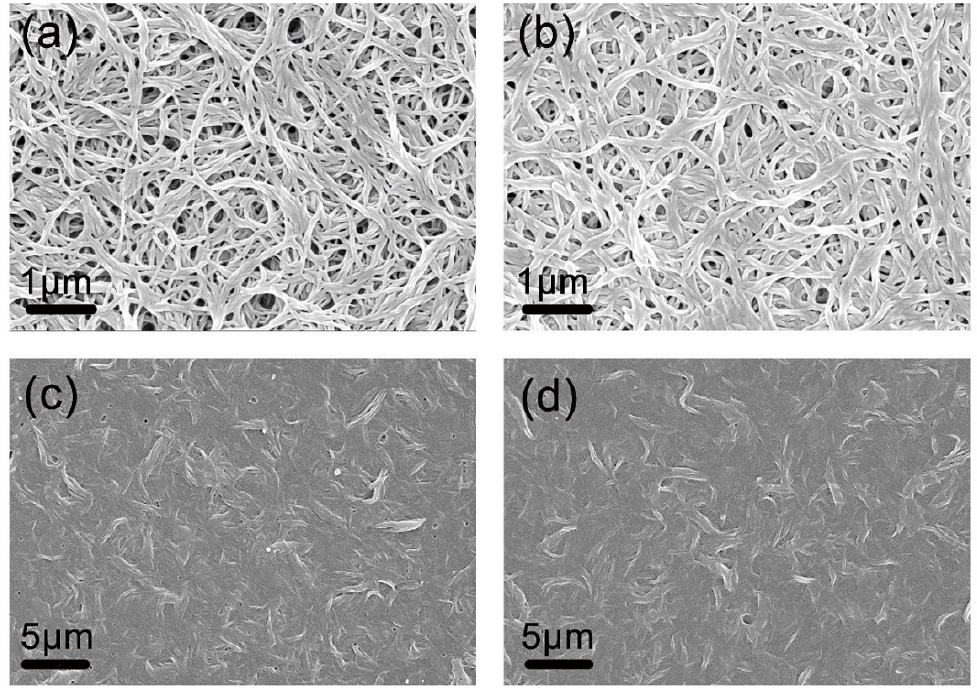
Figure 1. Microstructure of greases with different consistencies: ( a ) Li-230, ( b ) Li-300, ( c ) Po-230, ( d ) Po-300.